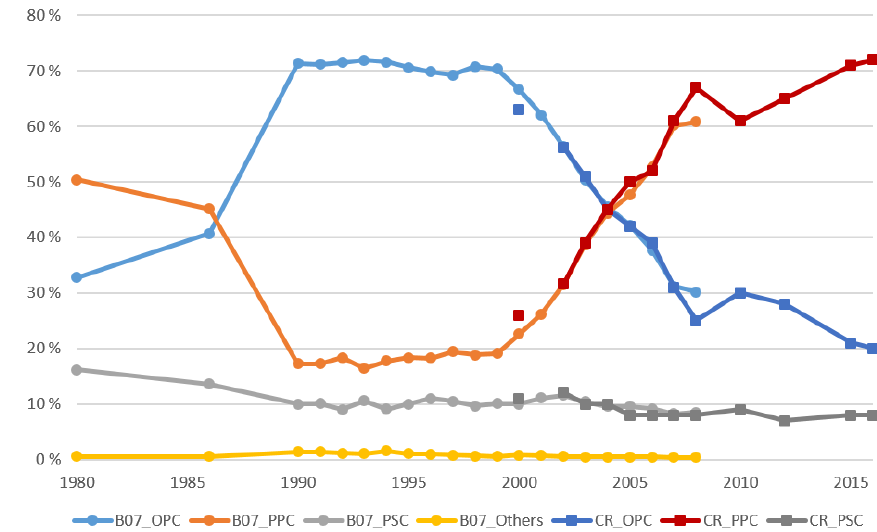
Figure C4. Proportions of cement production by type. B07: Bapata et al. (2007), CR: CRISIL (https://www.crisil.com/, last access: 31 March 2017). OPC: ordinary Portland cement, PPC: Portland pozzolana cement, PSC: Portland slag